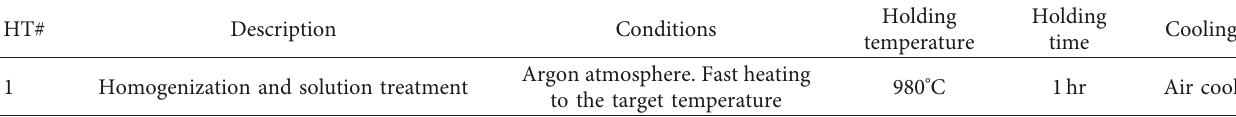
Table 4: Set 1: instructions for solution treatment (S).